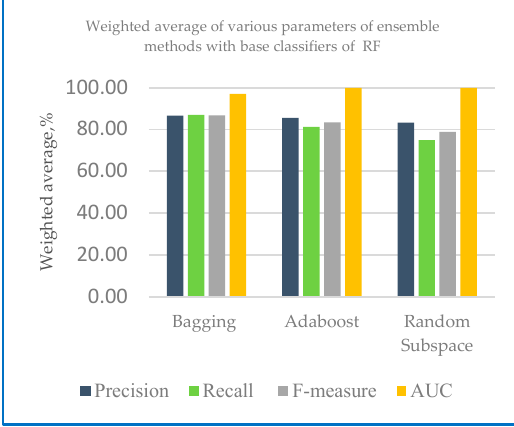
Figure 8. Weighted average of various parameters of ensemble methods with base classifiers of RF.